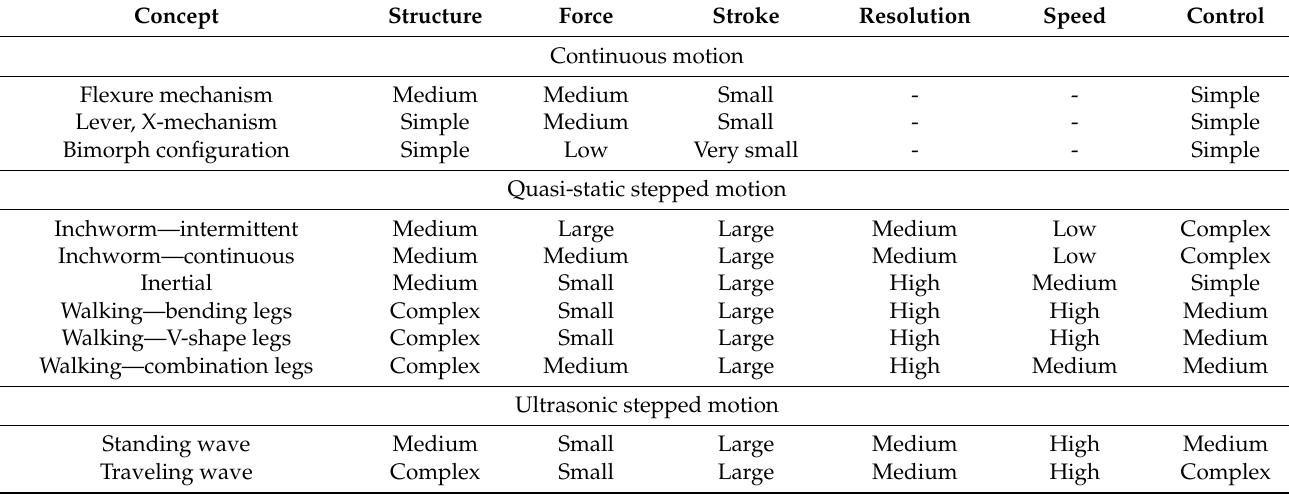
Table 9. Comparison of piezoelectric-based systems.